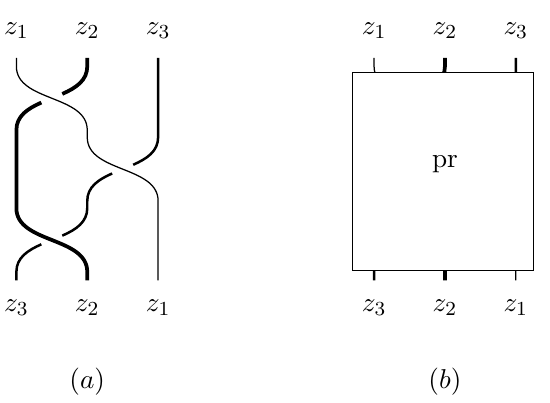
Figure 1: (a) A graphical representation of the braiding σ 1 , 2 σ 2 , 3 σ 1 , 2 of punctures z 1 , z 2 , and z 3 . (b) The projection pr forgets the details of the braiding, and just remembers the permutation performed on the punctures: the permutation (13) , which exchanges punctures z 1 with z 3 . g ∈ B , where B is the braid group on N strands. We denote by pr projection from n − p − 1 N the braid group B into the permutation group S n − p − 1 n − p − 1